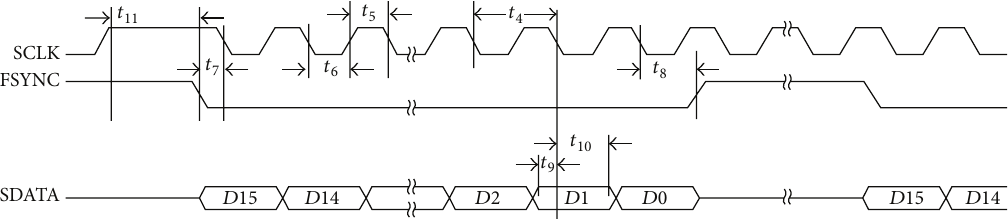
Figure 18: The sequence chart of DDS writing